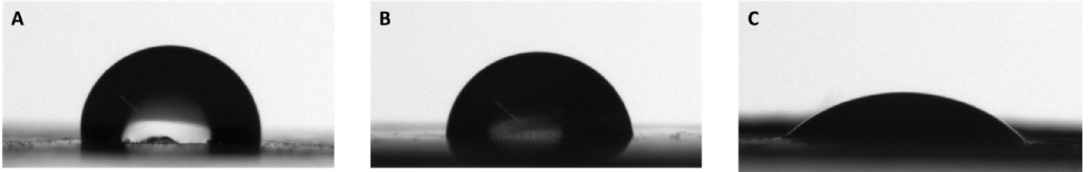
Figure 3. Water contact angle of bicomponent scaffolds of PCL/gelatin ( A ), PCL/zein ( B ), and PCL/keratin ( C ).